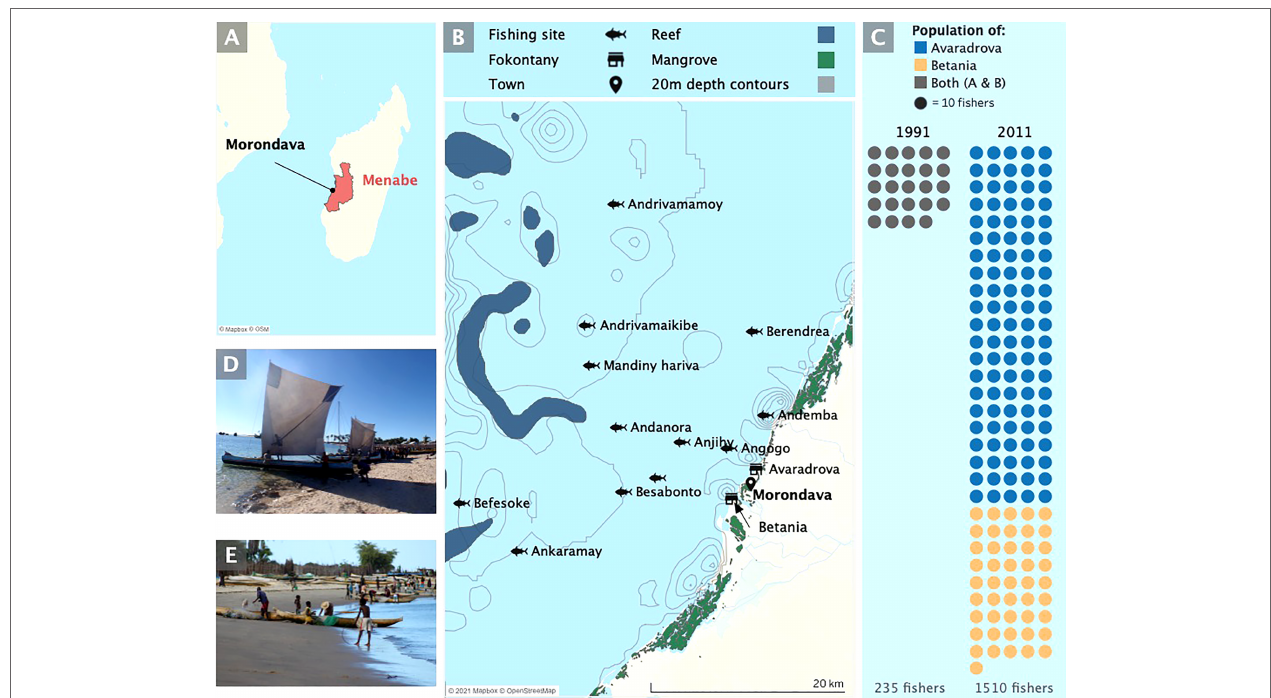
FIGURE 1 | Map of study site (A) Location of Madagascar off the east coast of Africa in the Mozambique channel, and Morondava in the region of Menabe, west Madagascar. (B) The two villages ( fokontany) of Betania and Avaradrova where landing surveys were carried out in both 1991 and 2011, and the commonly visited fishing sites recorded by fishers. (C) The number of fishers in each study as reported by village presidents (Note there was no village breakdown provided by Laroche et al., 1997). The two types of traditional boat used by the Vezo in the region’s small-scale traditional fishery (D) laka , and (E) molanga